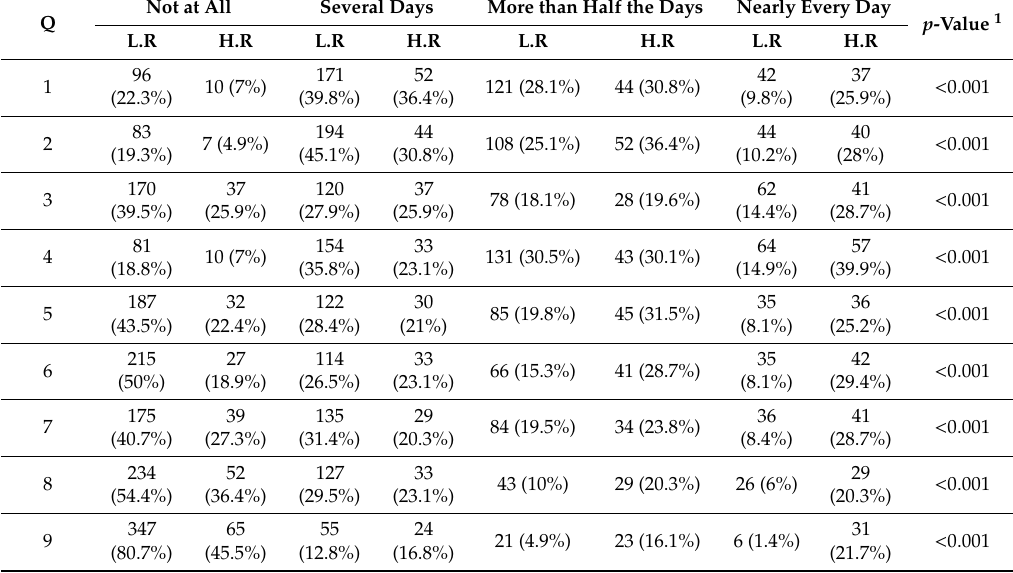
Table A5. Frequency of the Patient health questionnaire (PHQ-9) in low-risk (L.R) and high-risk (H.R) groups (Cut-o ff = 10).